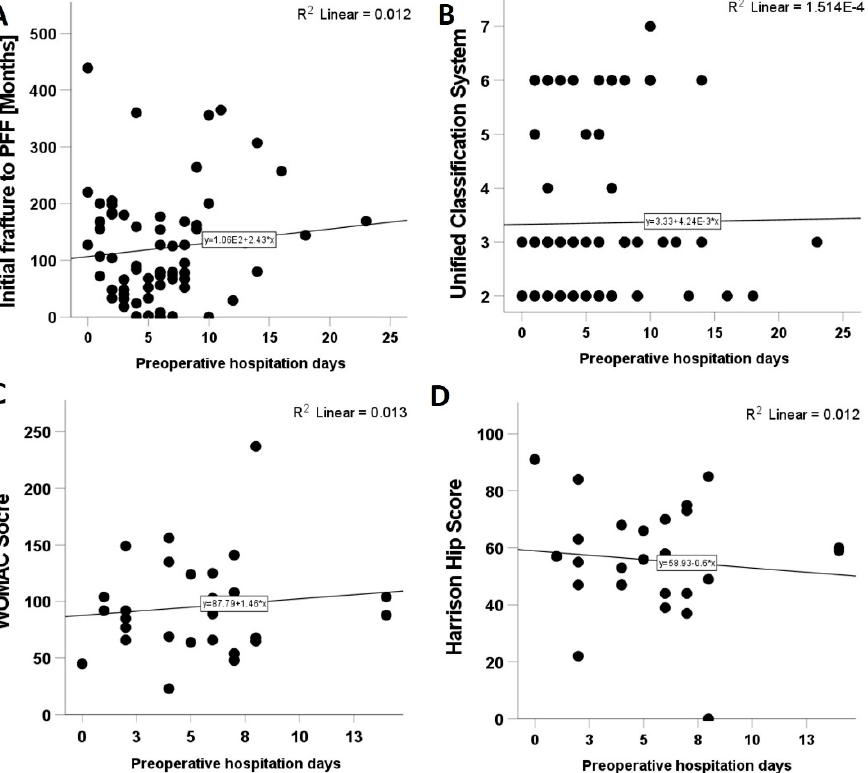
Figure 3. Correlation of preoperative hospitalization time with ( A ) initial time between initial fracture to PFF, ( B ) UCS severity, ( C ) the WOMAC score and ( D ) the Harris Hip score. Mortality risk is one of the most counted results in periprosthetic fractures studies.